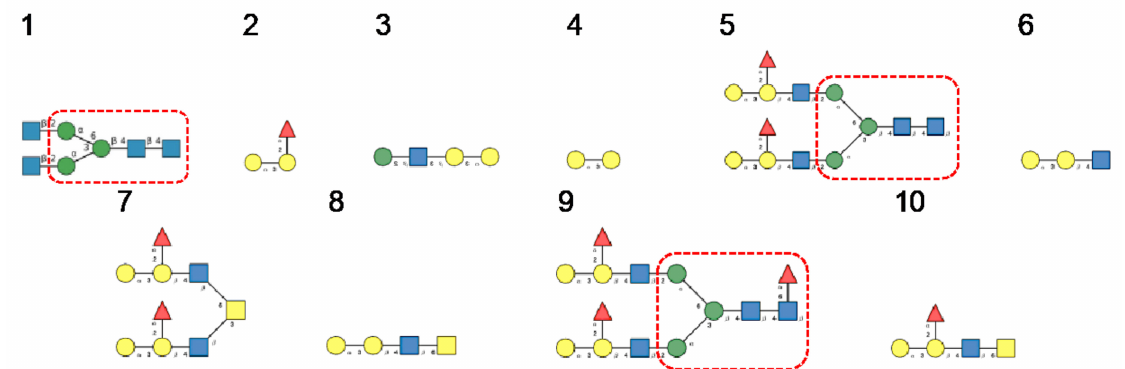
Figure 17. Glycans recognized by MOA in glycan array experiments, arranged from 1 to 10 in decreasing order of